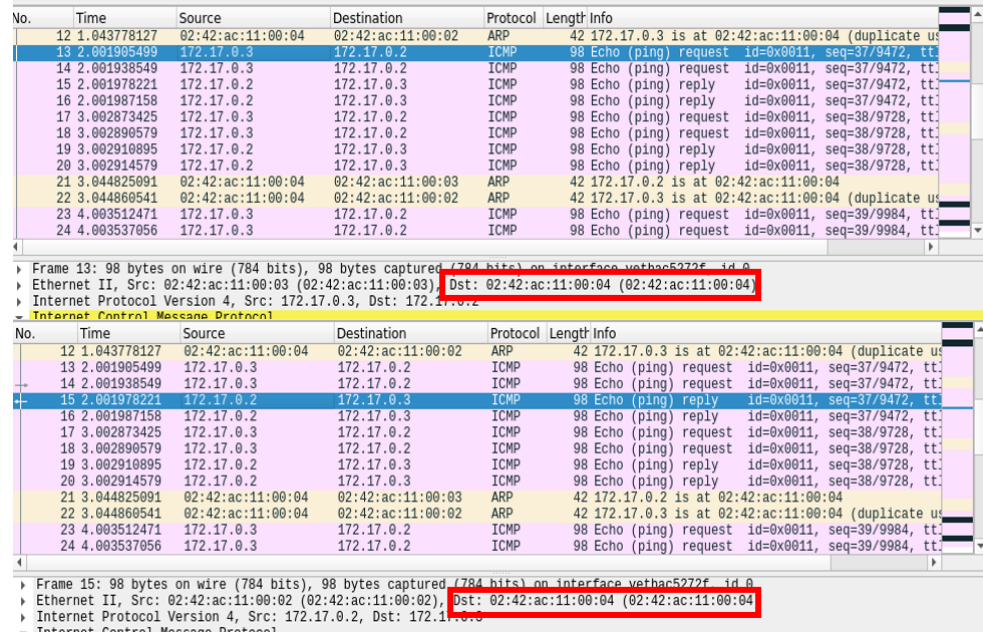
Figure 18. General ICMP communication process with the ARP spoofing attack.